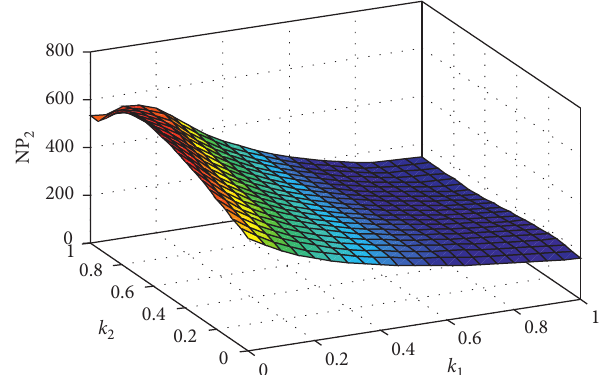
Figure 7: Relationship between the construction enterprise’s profit NP and the fairness concern behavior of both 2